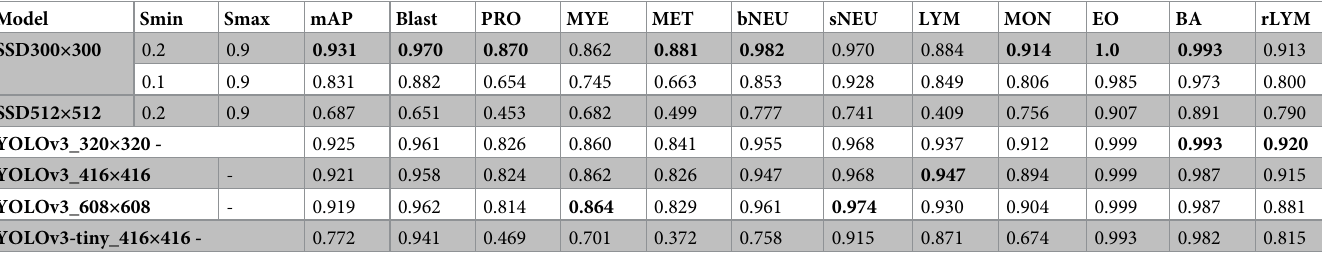
Table 1. Comparison of detection results using SSD and YOLOv3 series